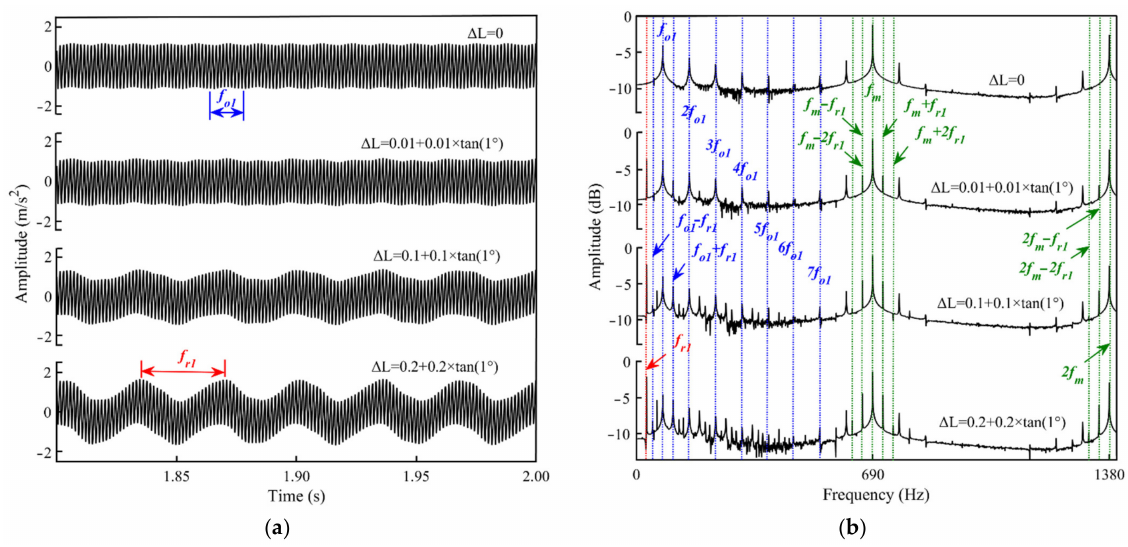
Figure 8. Vibration characters of the bearing-rotor-gear system with the misaligned rotor: ( a ) acceler- ation response; ( b ) frequency spectrum.